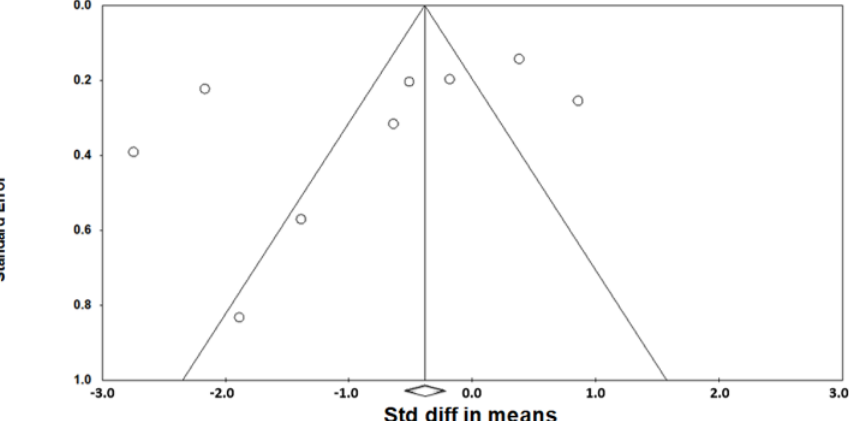
Figure 3. Funnel plot for the effects of pharyngeal obstructive sleep apnea surgery on the optimal positive airway pressure level. There was no publication bias (the Egger test p -value = 0.182). Std diff, standardized difference.